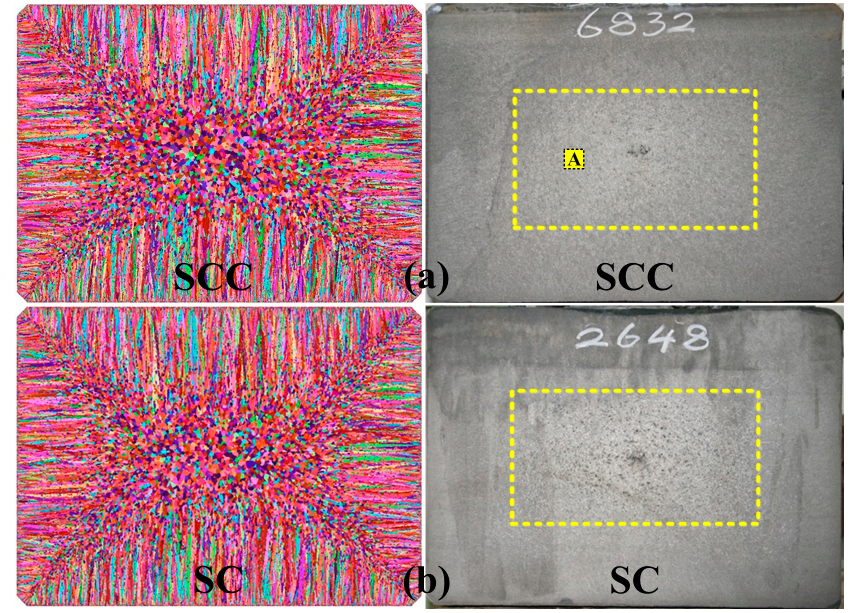
Figure 5. Comparison of numerical and experimental structure under SSC ( a ) and SC ( b ).